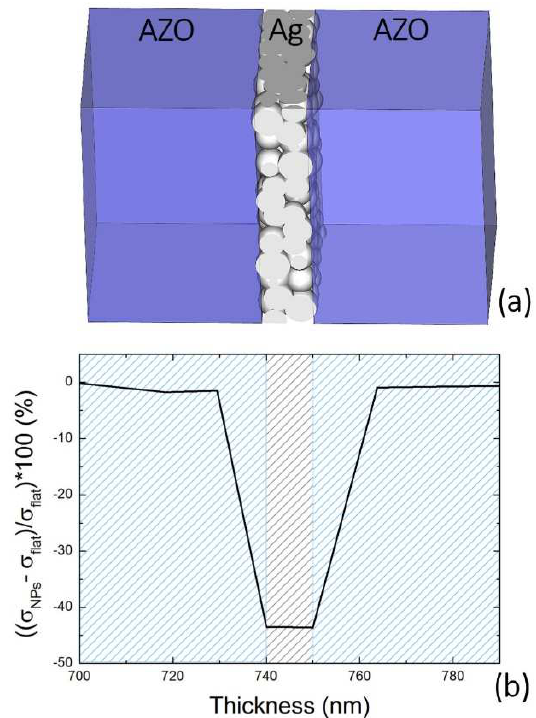
Figure 13. ( a ) Schematic of the sandwiched multilayer structure (AZO/Ag/AZO) described in the experiment. ( b ) Relative difference variation of the stress σ for the Ag sputtered film ( σ flat ) and the AgNPs ( σ NPs ) normalized against σ flat versus the multilayer depth. Adapted from ref. [7].